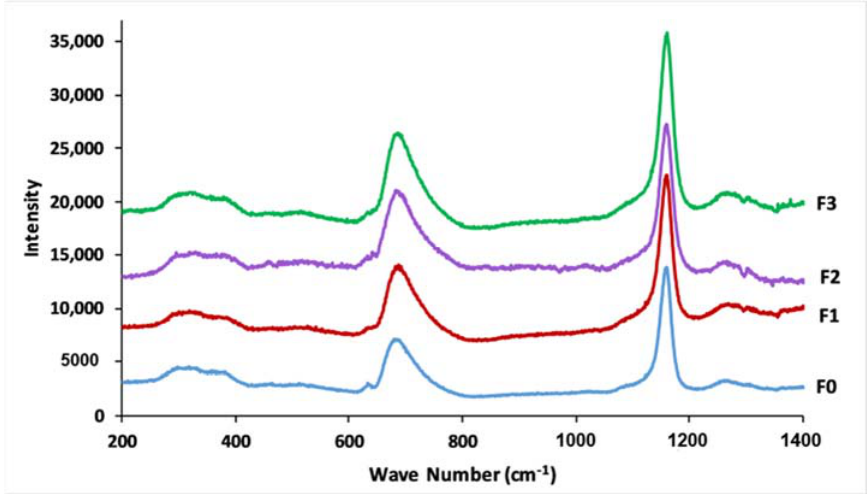
Figure 5. Raman spectra of prepared glasses.